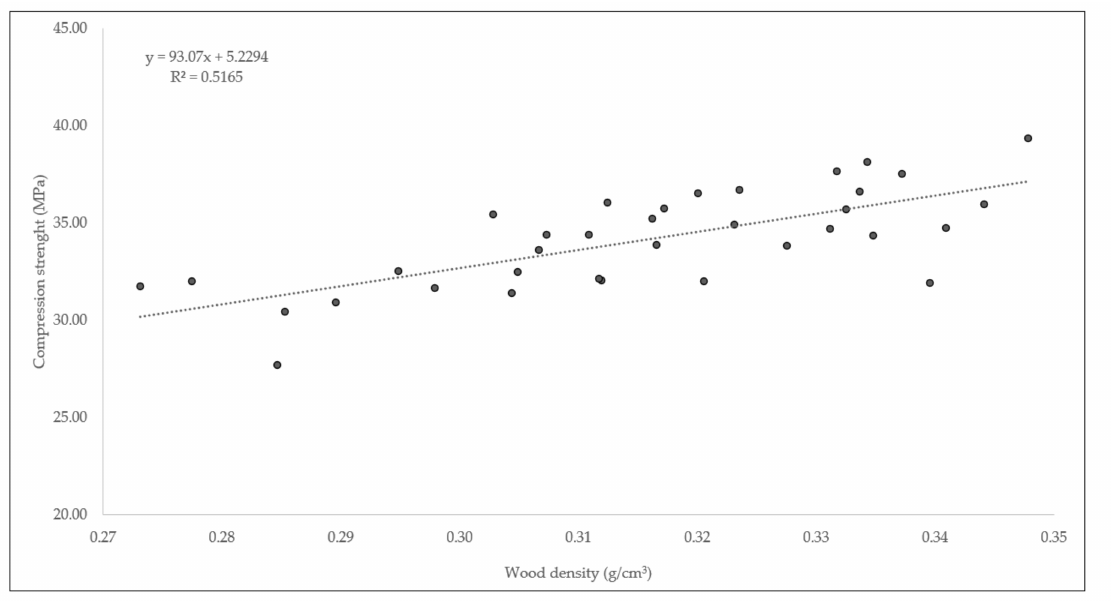
Figure 1. Compression strength of heat-treated ayous wood in function of density referred to MC 12%.